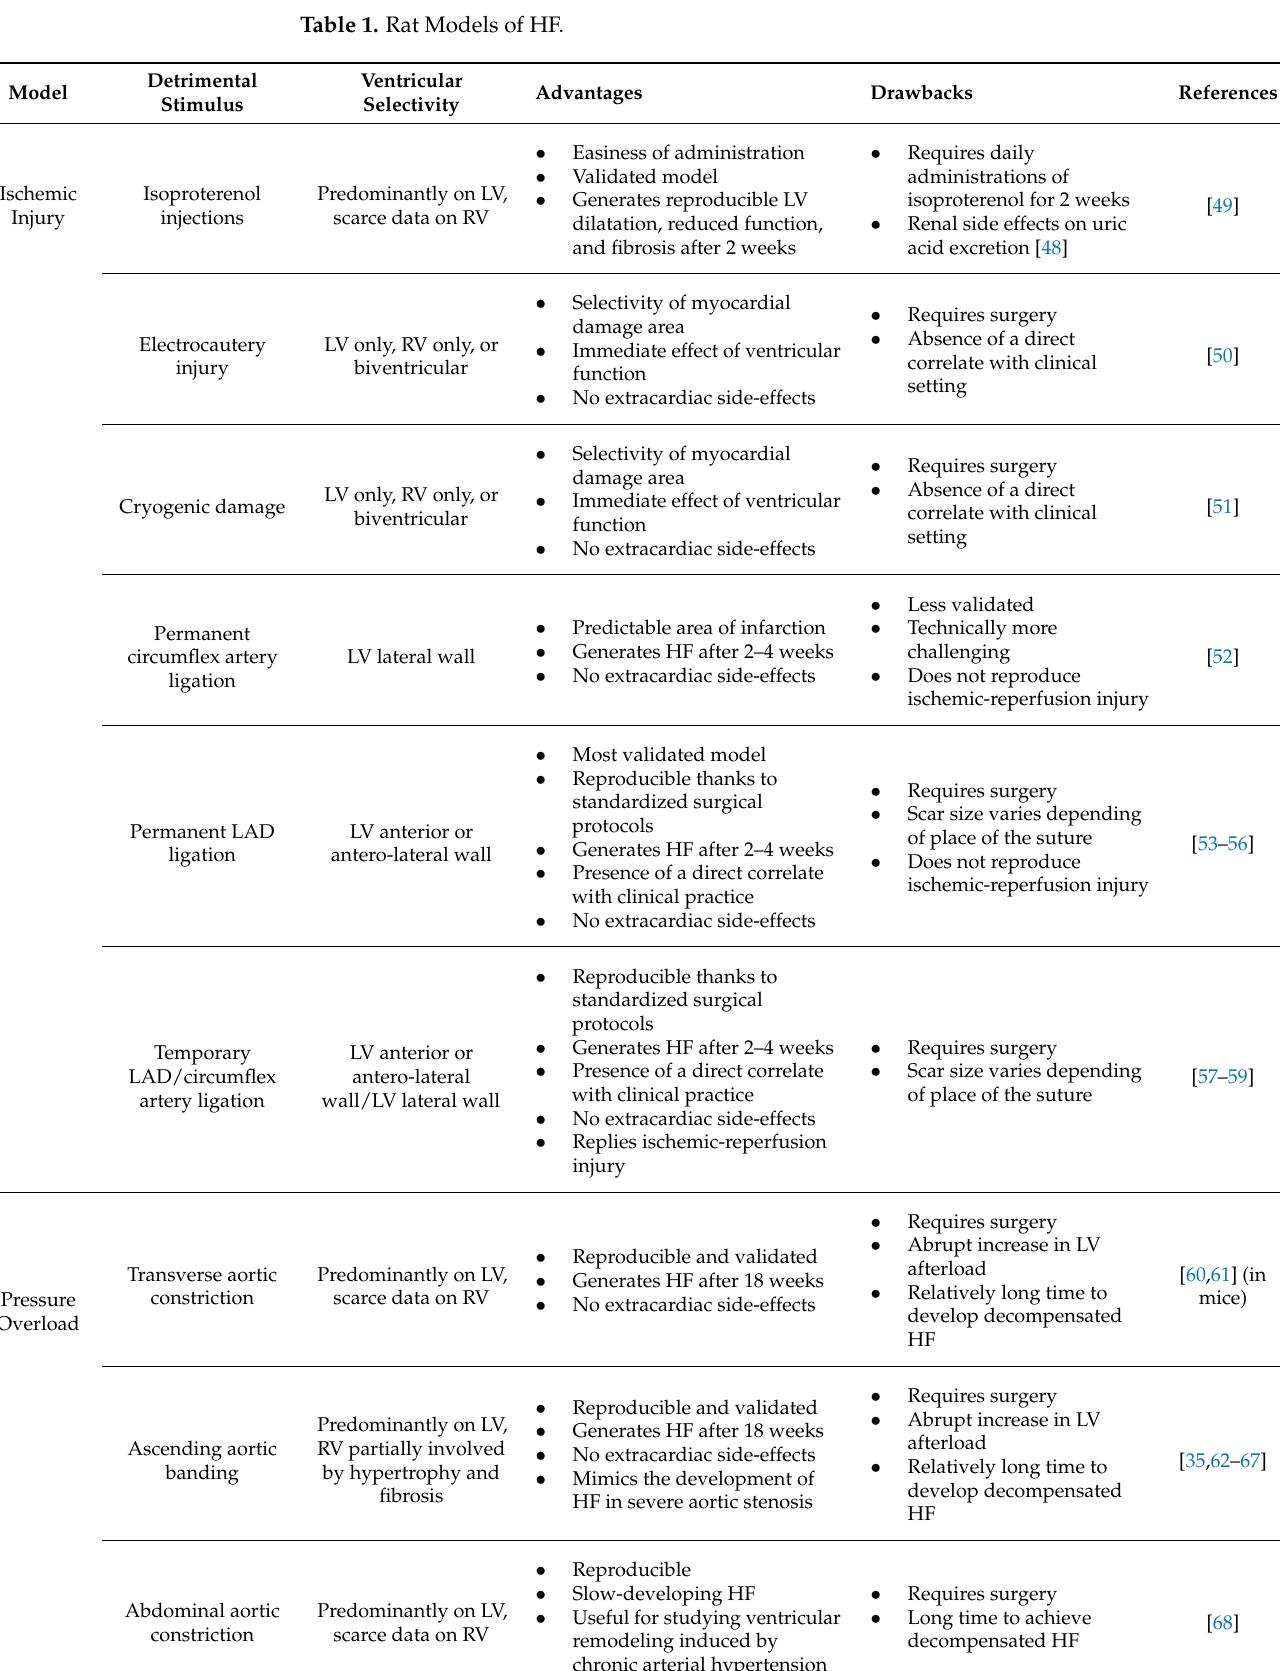
Table 1. Rat Models of